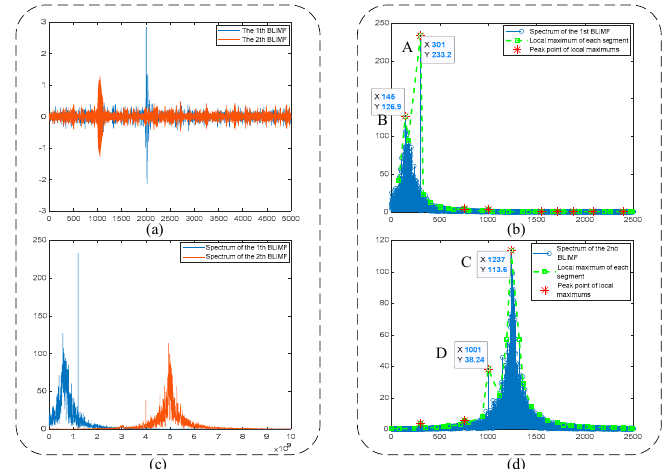
Figure 4. Optimization process when k = 2: ( a ) Time-domain waveforms of BLIMFs; ( b ) Local maximums of 1st BLIMF and its peak points; ( c ) Spectra of BLIMFs; ( d ) Local maximums of 2nd BLIMF and its peak points.